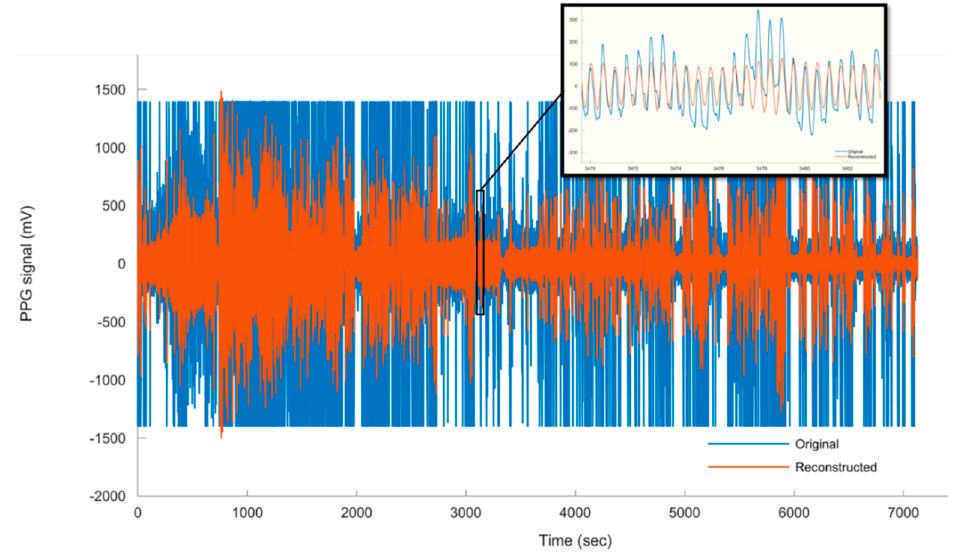
Figure 10. The raw PPG signal vs. the decoupled (reconstructed) cardiac pulse waves obtained from moving pig.